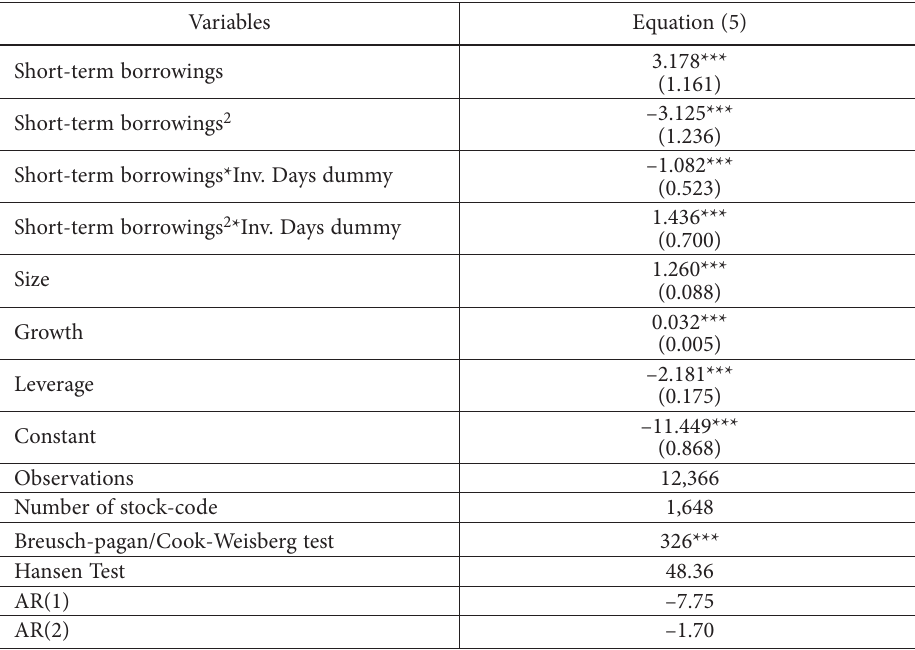
Table 7. Short-term borrowings and Profitability for firms carrying reduced and extended inventory